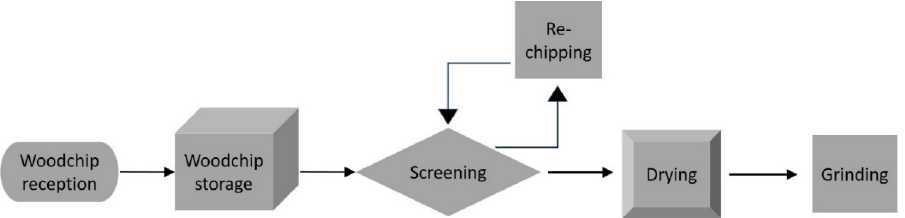
Figure 3. Pre-treatment process before pyrolysis of the biomass.